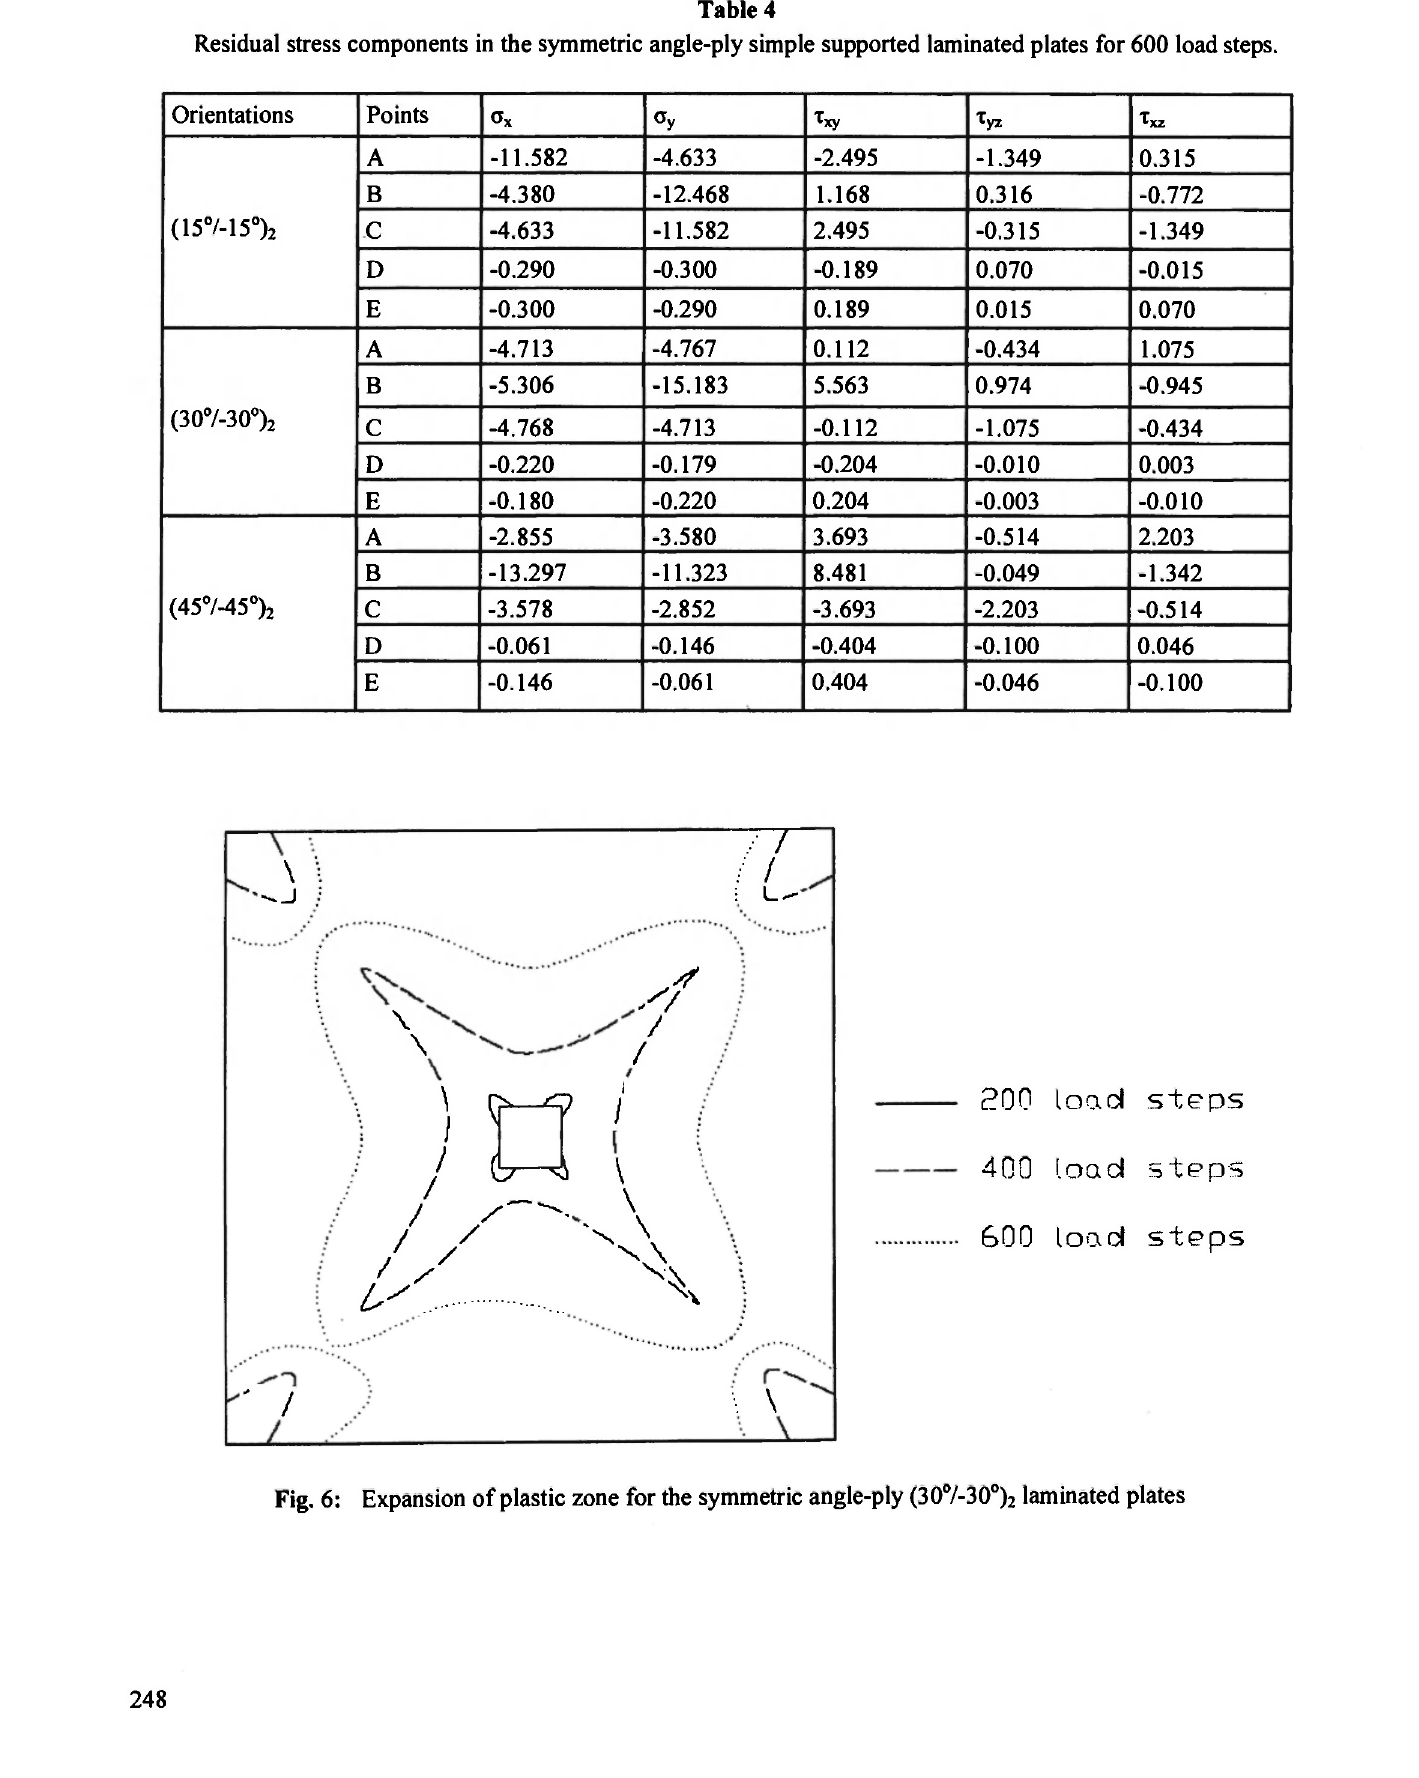
Fig. 6: Expansion of plastic zone for the symmetric angle-ply (307-30°) 2 laminated